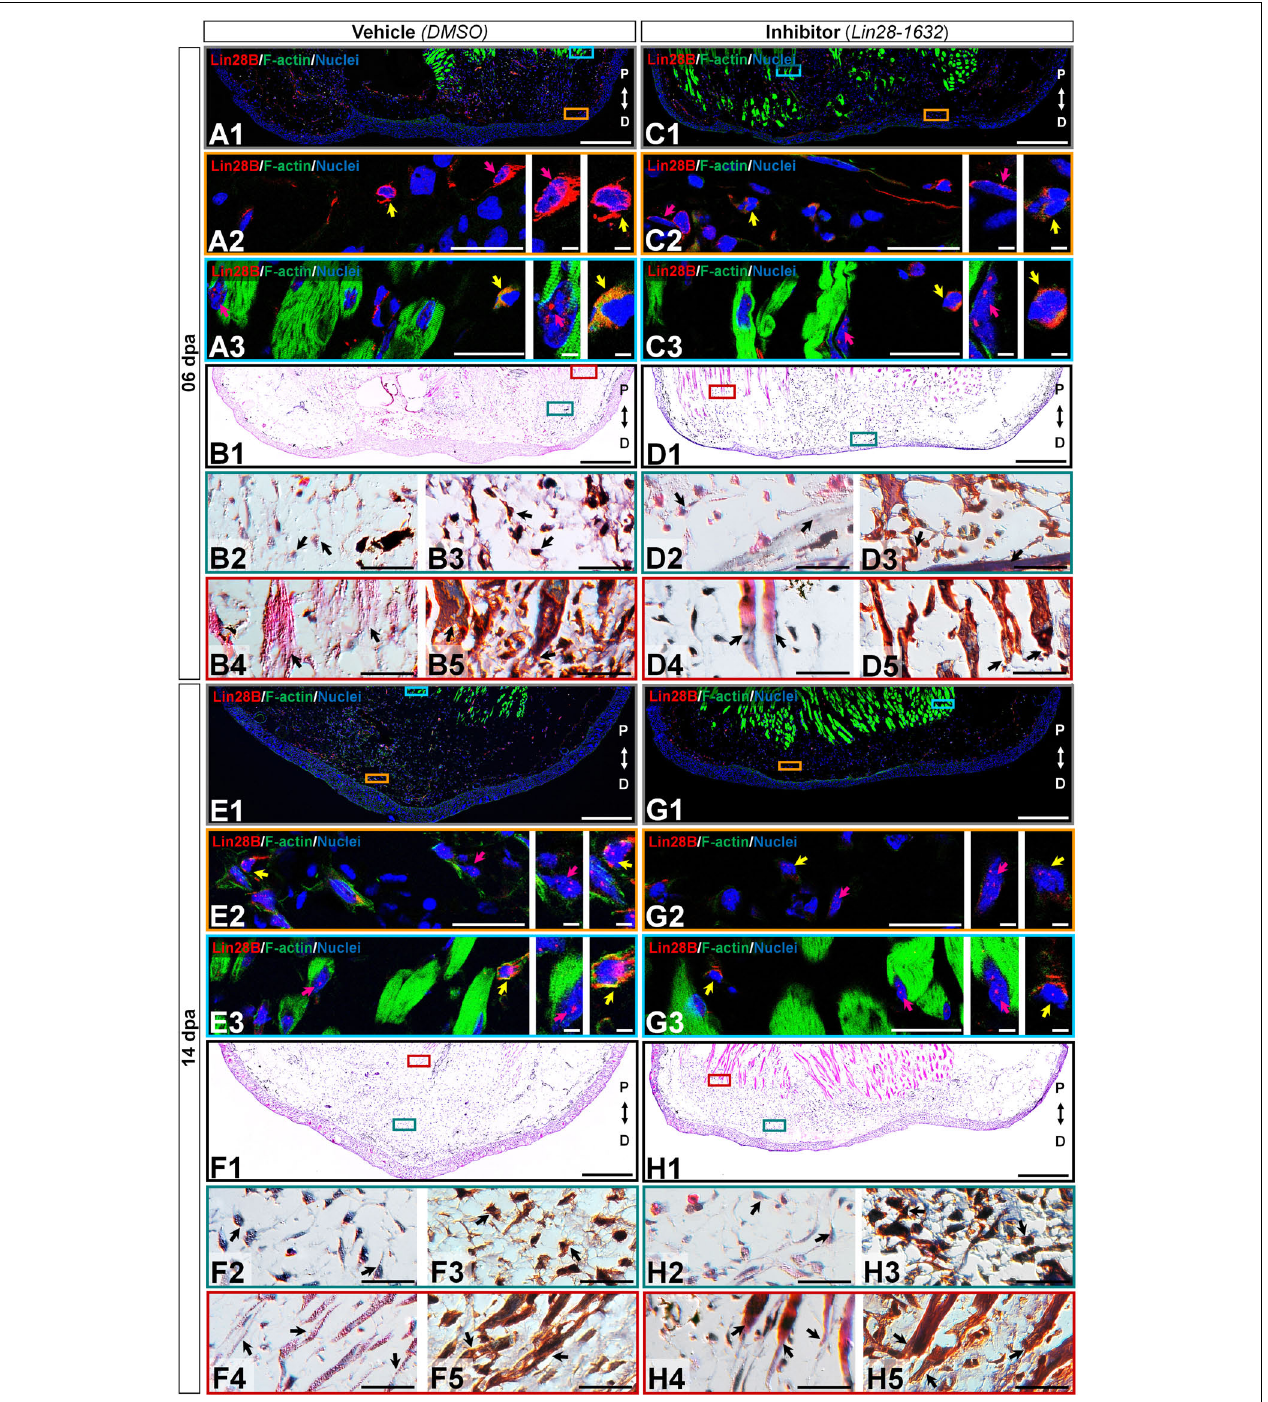
FIGURE 7 | Histological changes after functional inhibition of Lin28 in key regeneration stages. (C,D,G,H) Histological sections of limbs treated with Lin28-1632 inhibitor, oriented in the Proximal-Distal axis. (A,B,E,F) Histological sections of limbs treated with vehicle, oriented in the Proximal-Distal axis. (A–D) Apical epidermal cap stage (06 dpa). (E–H) Early blastema stage (14 dpa). (A1,C1,E1,G1) Subcellular localization of amxLin28B marked in red, by contrast with DAPI (blue) and Phalloidin (green). Scale bars: 500 µ m. (A2-3,C2-3,E2-3,G2-3) Magnifications with different color contours to remark some areas of interest for amxLin28B in red, DAPI in blue, and Phalloidin in green; arrows in yellow and magenta have in turn their own zoom in. Scale bars: 50 and 5 µ m, respectively. (B1,D1,F1,H1) General tissue morphology shown with Hematoxylin & Eosin staining. Scale bars: 500 µ m. (B2/4,D2/4,F2/4,H2/4) Magnifications with distinct color contours to indicate some areas of interest in Hematoxylin and Eosin staining. Scale bars: 50 µ m. (B3/5,D3/5,F3/5,H3/5) Differential staining to view changes on stroma for similar zones indicated in H&E ampliations. Scale bars: 50 µ m. The distinct arrows point to diverse tissue components, as described in the results.